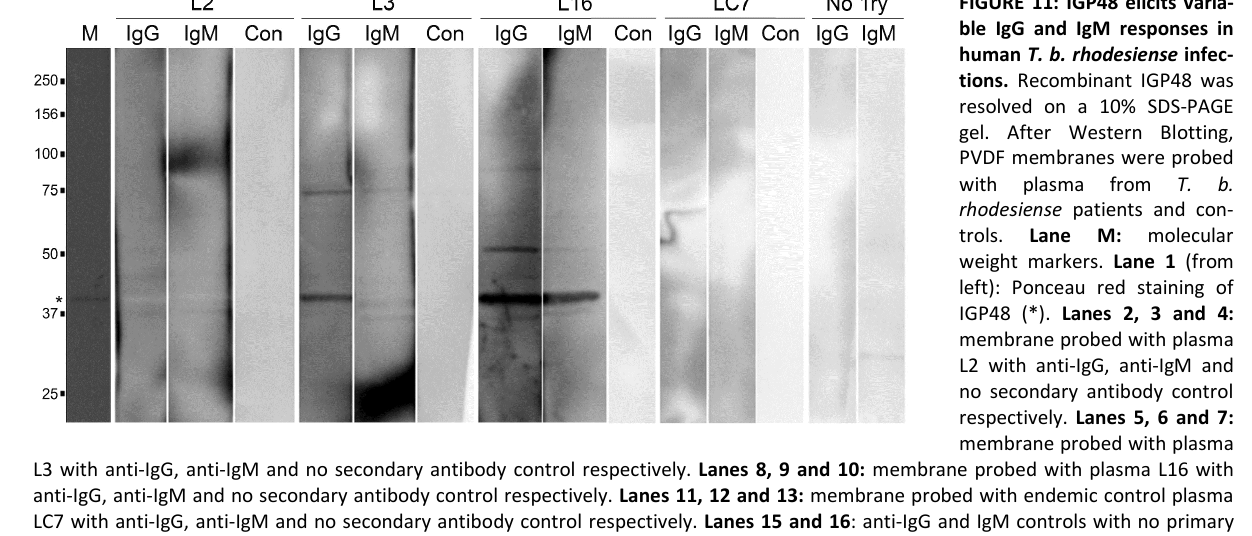
L3 with anti-IgG, anti-IgM and no secondary antibody control respectively. Lanes 8, 9 and 10: membrane probed with plasma L16 with anti-IgG, anti-IgM and no secondary antibody control respectively. Lanes 11, 12 and 13: membrane probed with endemic control plasma LC7 with anti-IgG, anti-IgM and no secondary antibody control respectively. Lanes 15 and 16 : anti-IgG and IgM controls with no primary